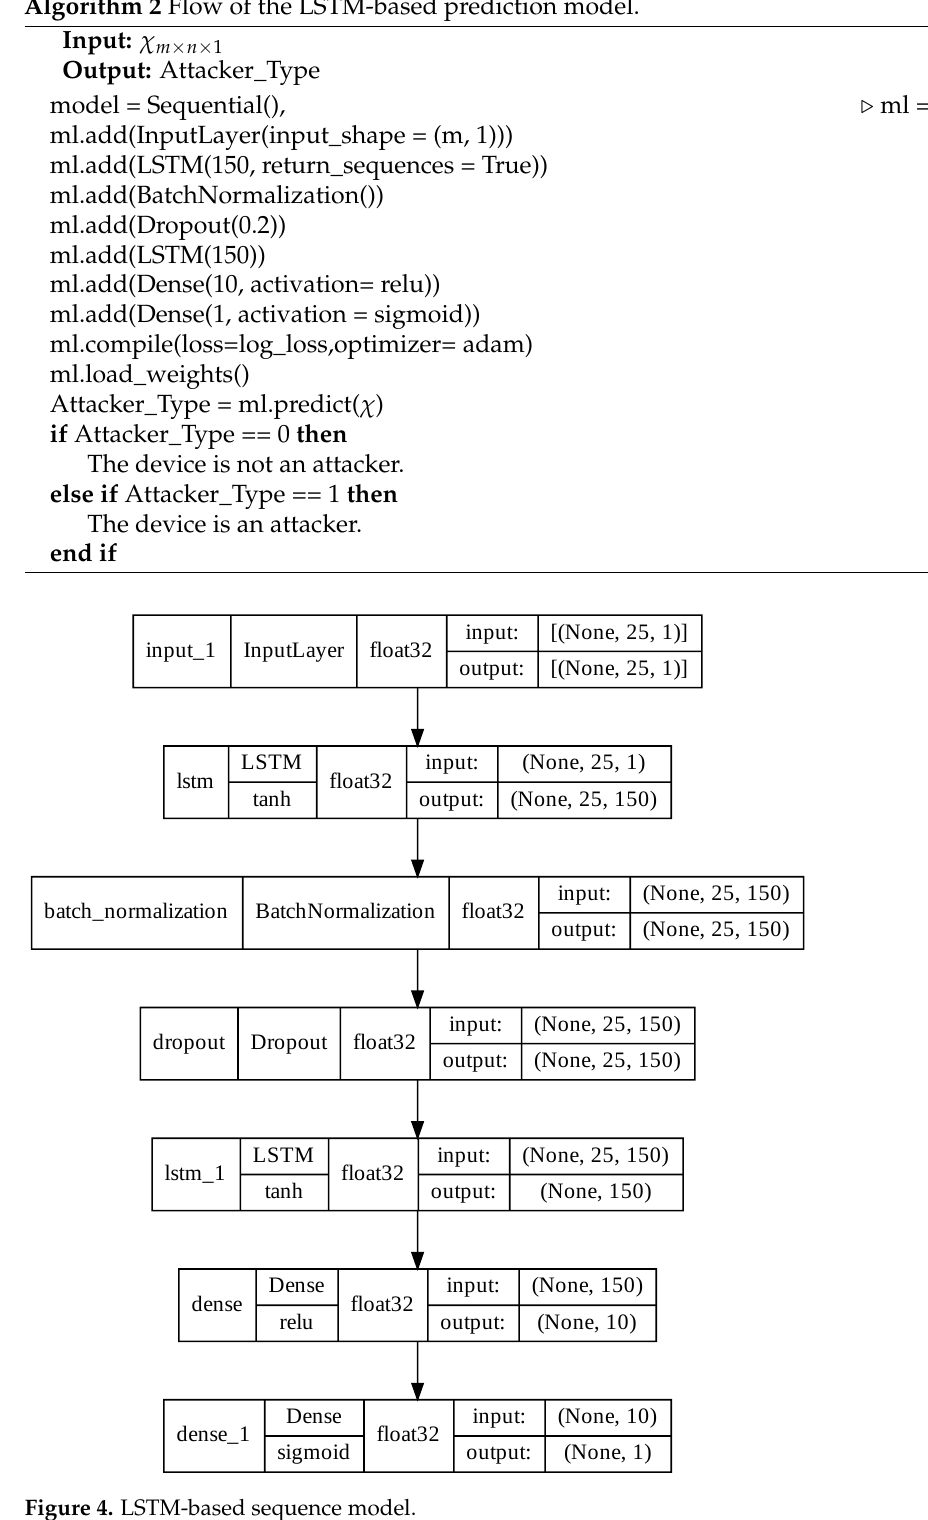
Algorithm 2 Flow of the LSTM-based prediction model.